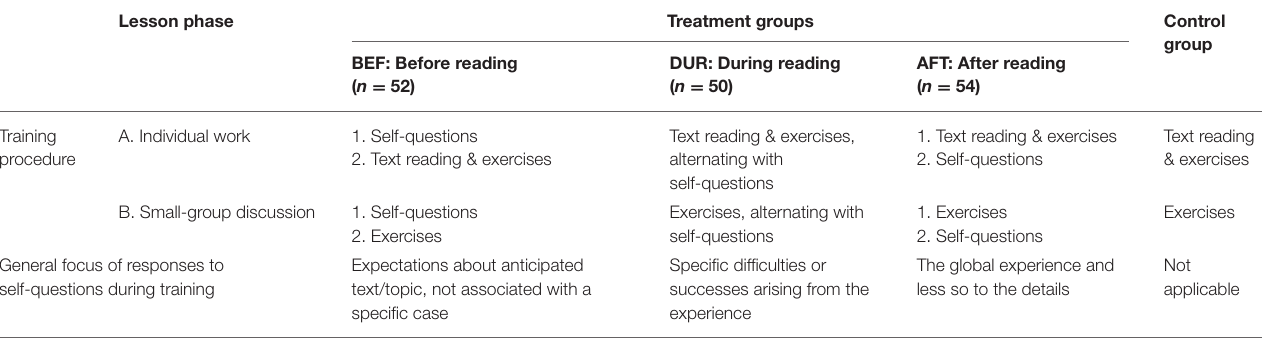
TABLE 1 | Four groups’ training conditions (Modeled in lessons 1 and 2 and practiced in lessons 3 and 14). Lesson phase Treatment